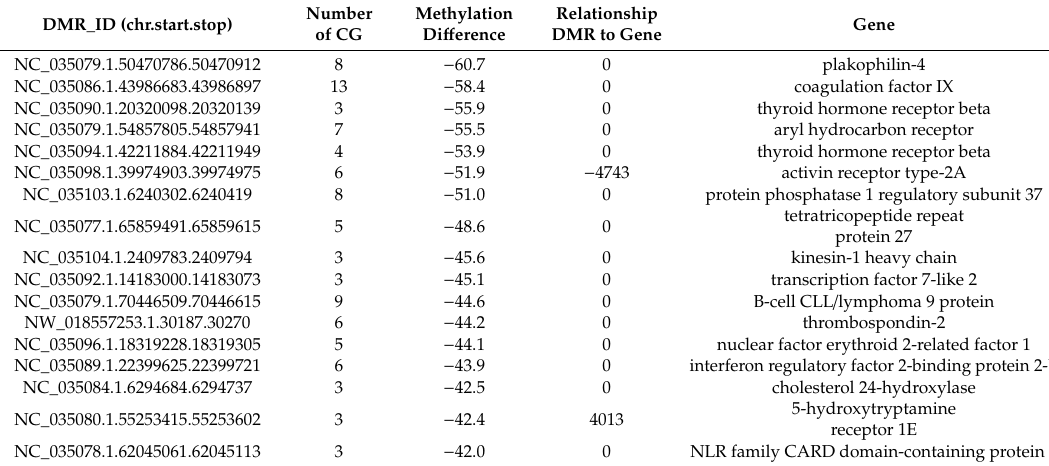
Table 3. Developmental di ff erentially methylated regions (DMRs) with the most extreme methylation di ff erences( > 40%). Themethylationdi ff erenceisrelativetotheage-1samples, withnegativemethylation di ff erences indicating a loss of methylation in the age-2